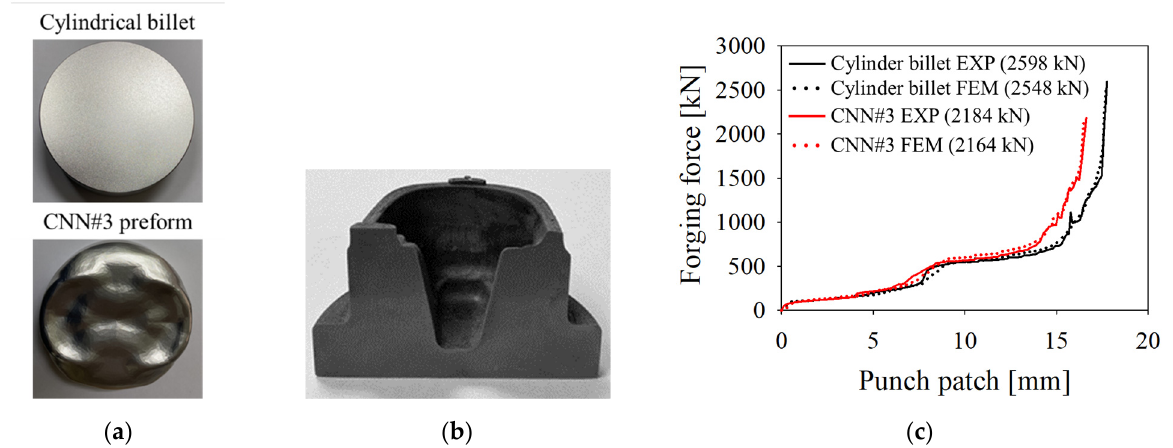
Figure 21. ( a ) Cylindrical billet and CNN#3-based preforms, ( b ) cross-section of the forged piston head with the CNN#3- based preform, and ( c ) forging force–punch patch curves obtained from experiments and FEM simulations.